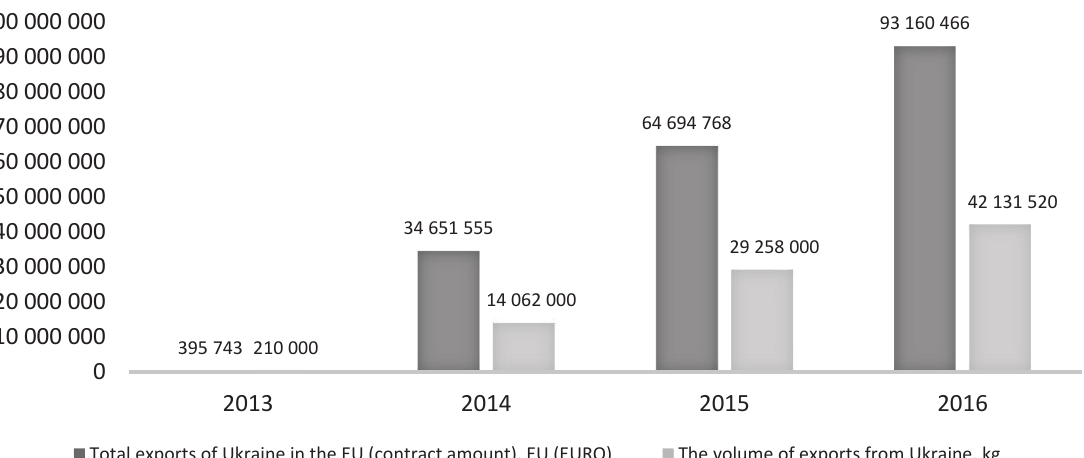
Figure 7. Analysis of Ukraine’s chicken meat exports to the EU in 2013‒2016